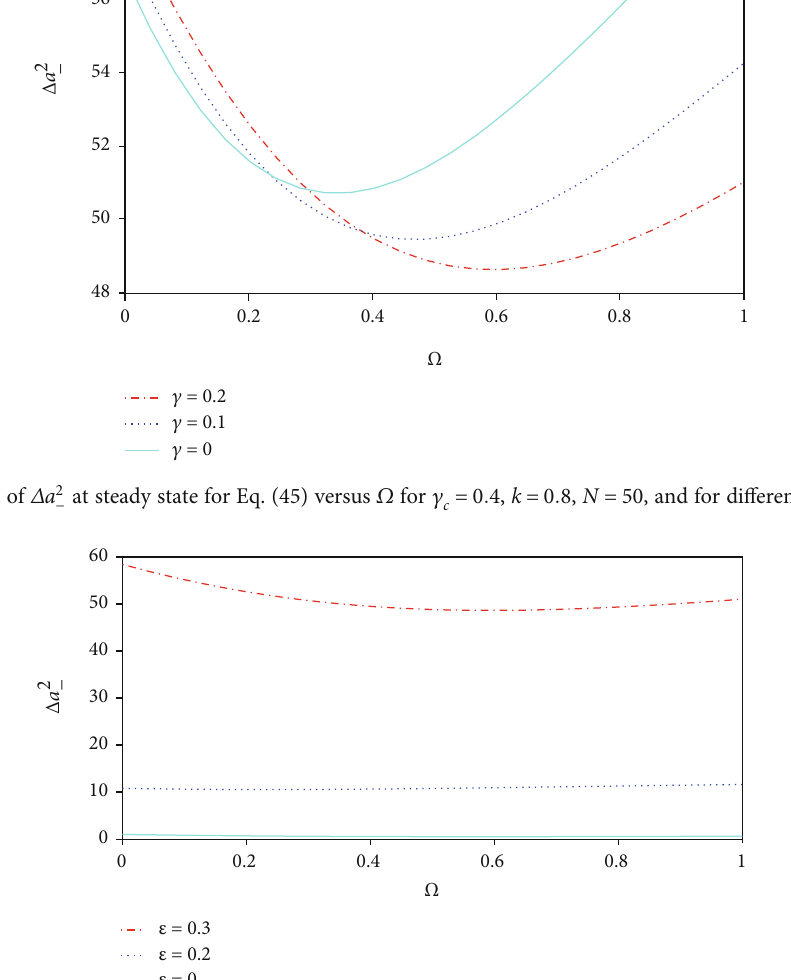
Figure 3: Plot of Δ a 2 − at steady state for [Eq. (45)] versus